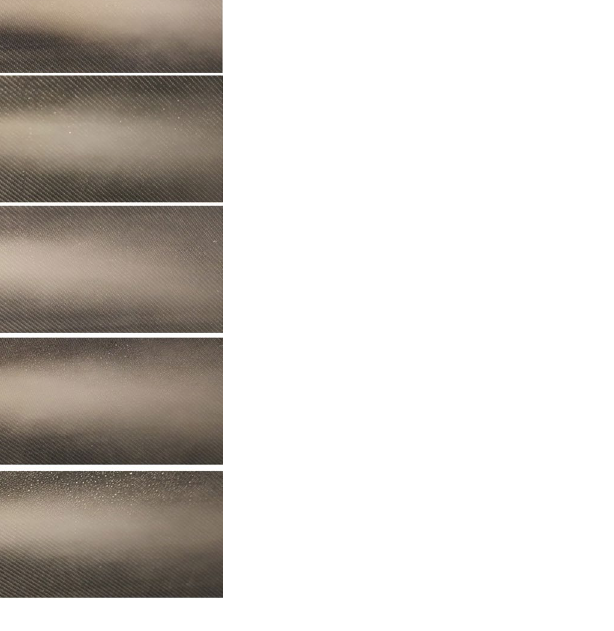
Figure 4. Spray angle of different